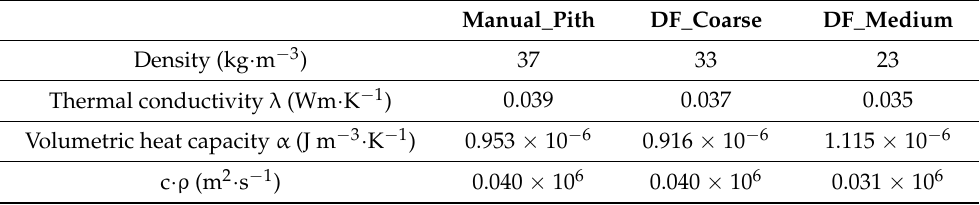
Figure 3. Visualization of pith particles isolated manually ( a , b ) or by dry fractionation process (‘DF_coarse’: d , e ; ‘DF_medium’: g , h ) and insulative board prepared with these pith fractions ( c , f , i ). Optical microscopy of isolated fractions ( a , d , e ), SEM microscopy o section of pith particle from each pith fraction ( b , e , h ); Insulative board prepared from each fraction ( c : manual pith fraction, f : ‘DF-coarse’ pith fraction, i : ‘DF_medium’ pith fraction). Table 1. Density and thermal properties of insulating boards prepared with three maize pith fractions either manually extracted (“manual pith”) or obtained after dry fractionation process (‘DF_coarse’ and